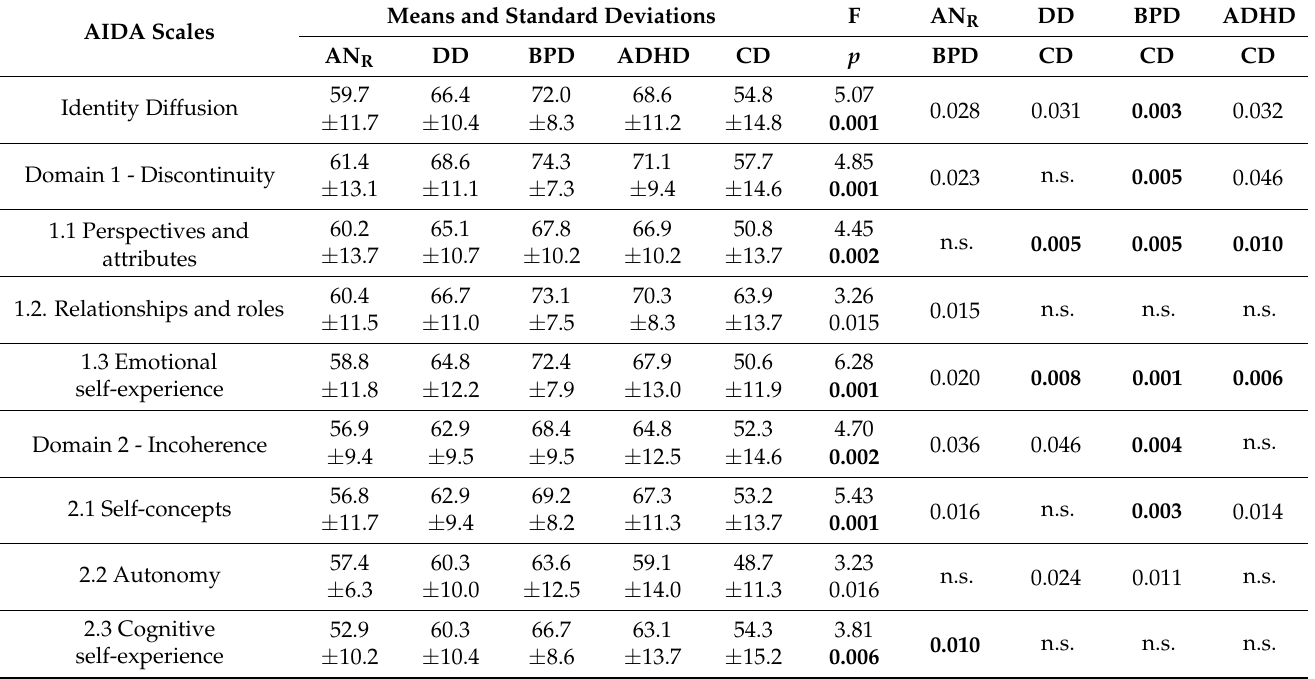
Table 4. Means and standard deviations of t-values for the total scale of identity diffusion, pri- mary scale of discontinuity and incoherence, and subscales of Assessment of Identity Develop- ment in Adolescence (AIDA) for mental-disorder groups. One-way analysis of variance (ANOVA) was conducted with Bonferroni post hoc test analysis to examine the differences between groups. Only samples with Bonferroni post hoc test calculations that included significant values are listed ( α -level ≤ 0.01 (bold print), α -level ≤ 0.05 (light print)); n.s. = not